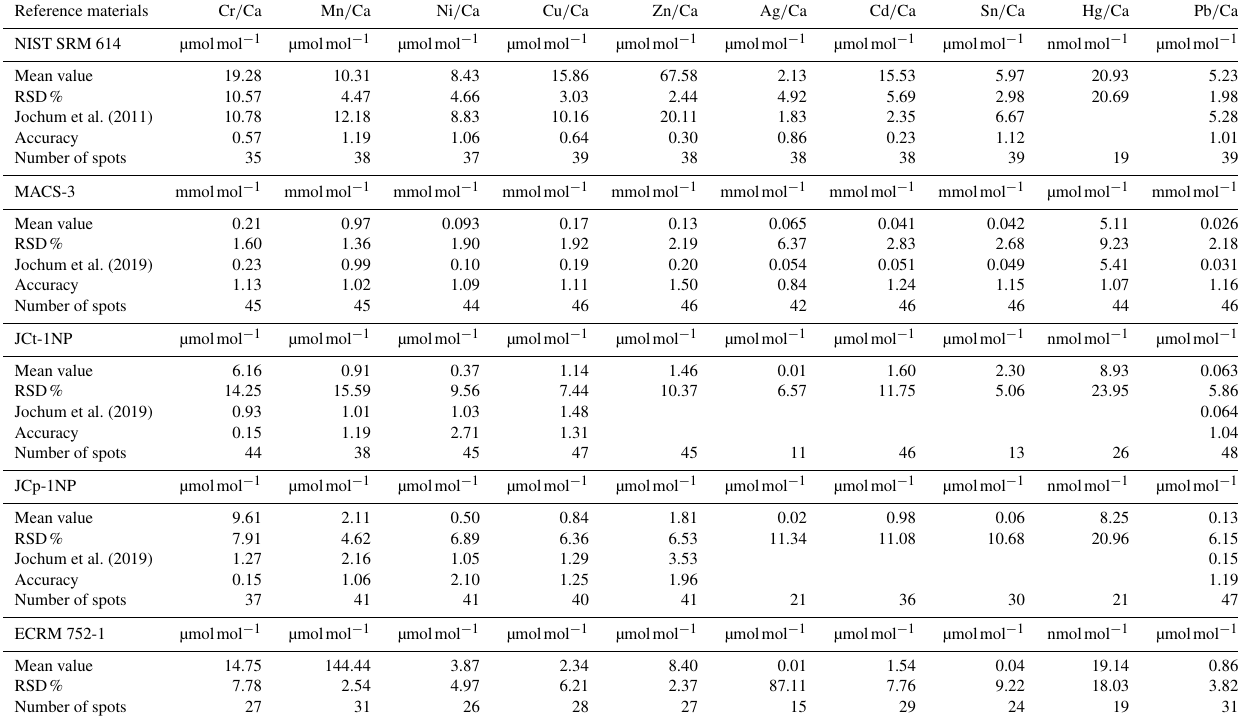
Table A3. Average concentration; RSD (1 σ in %); literature values; accuracy in comparison to literature values; and number of measurements of the reference materials NIST SRM 614, JCt-1, JCp-1, MACS-3 and ECRM 752-1 measured with LA-ICP-MS. JCt-1NP and JCp-1NP indicate JCt-1 and JCp-1 analysed in the form of nano-particle (NP) pellets. Please note that for ECRM 752-1 no reported values for the elements of interest are available, which is also the case for some elements in other reference materials. It is important to note that the Hg / Ca values in the NIST glasses are not reliable as Hg is volatile and most likely volatilised during the glass formation. Average concentration, RSD and accuracy values displayed here are averaged from single measuring days.